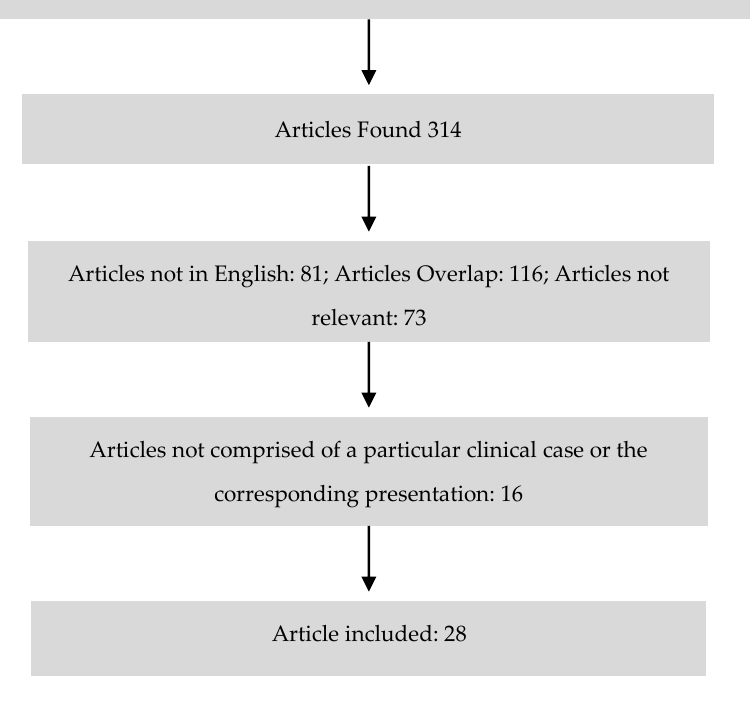
Figure 1. Electronic Literature Search for ACM Cases.